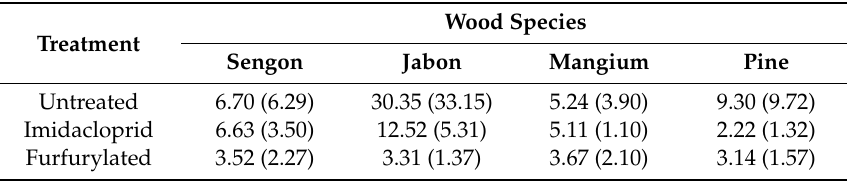
Figure 3. Wood specimens after three months of exposure in the field. Table 2. Weight loss of wood specimens (%). a